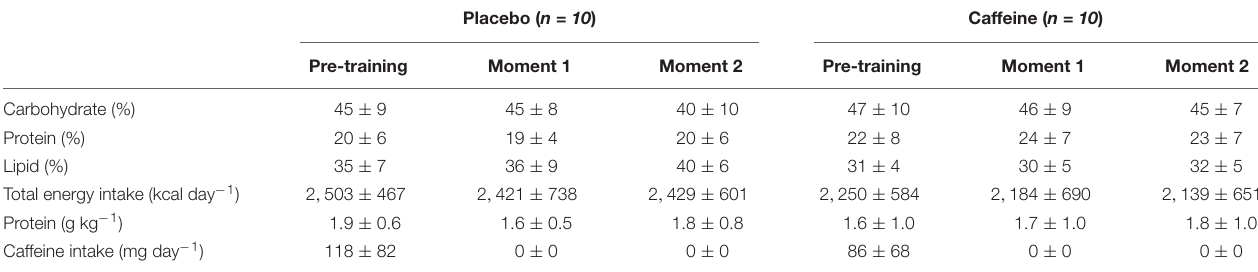
TABLE 2 | Food records 24 h before (pre-training), and at two randomly-chosen training moments (moment 1 and 2), during the training